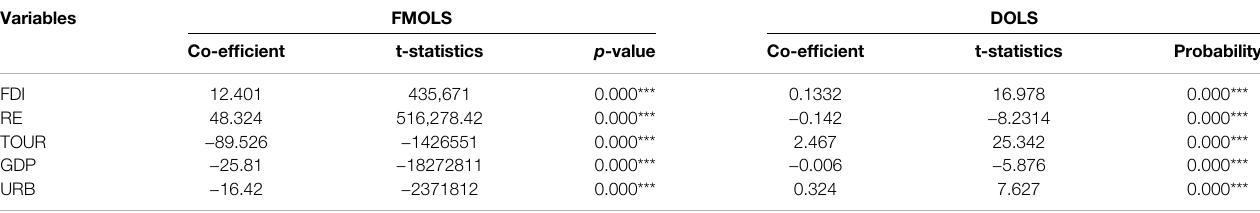
TABLE 4 | Long-run valuation of DOLS and FMOLS